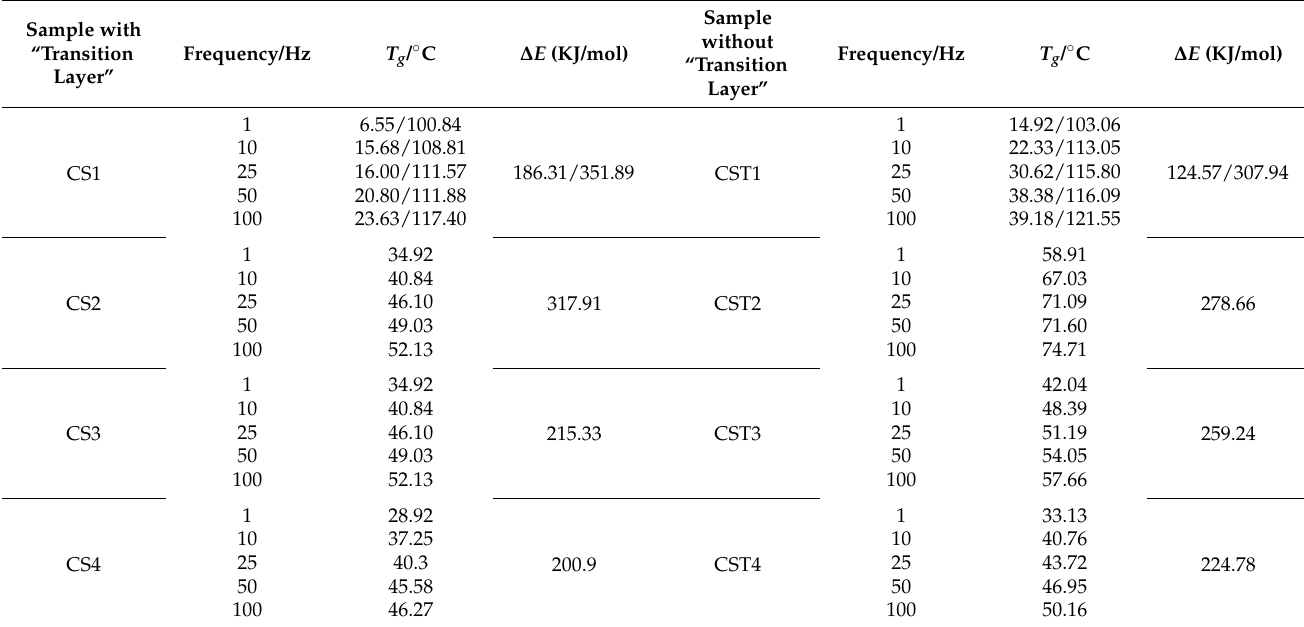
Figure 6. Plot of ln ( ω ) versus (1/ T g ) of latex. Table 5. T g and ∆ E of